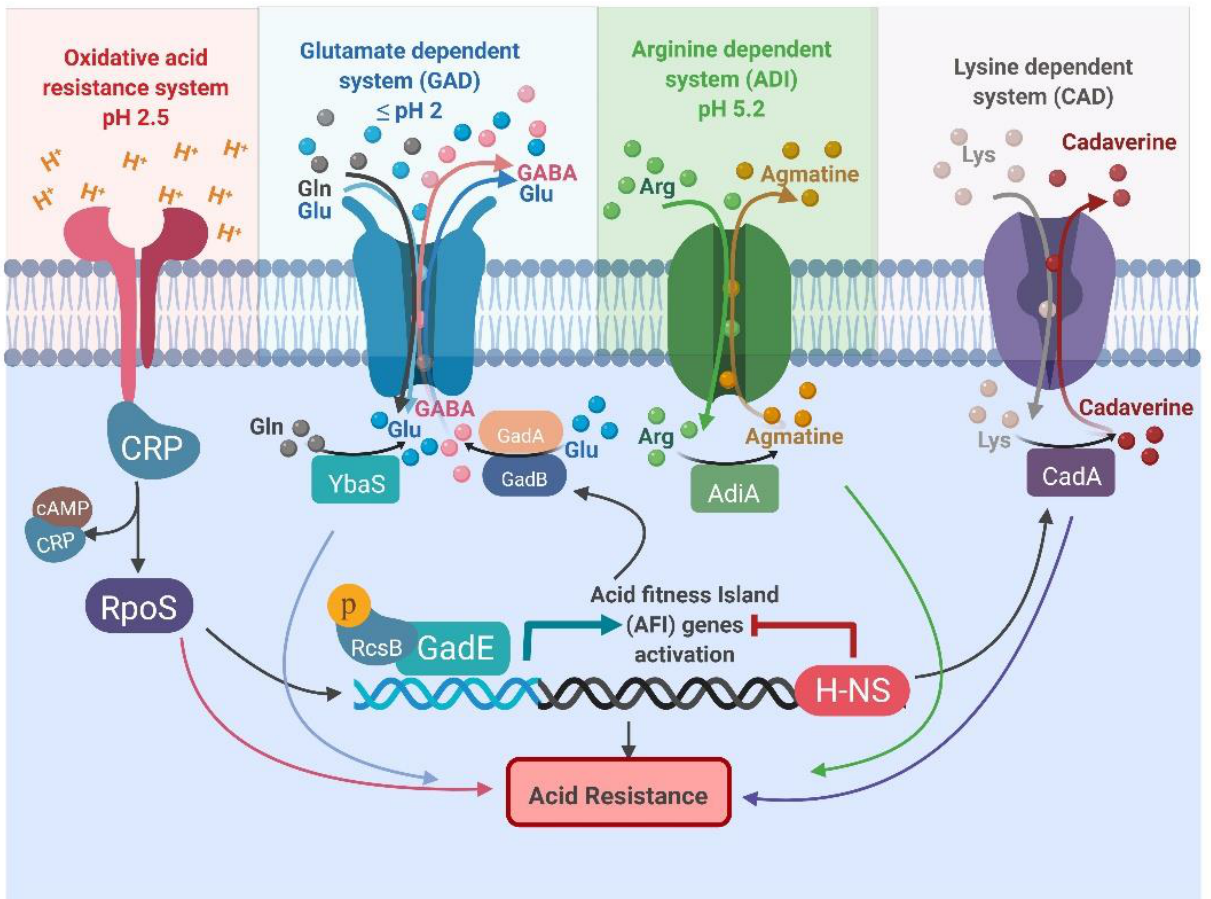
Figure 1. Representation of the oxidative, glutamate-dependent, arginine-dependent, and lysine-dependent acid resistance systems in Escherichia coli . All abbreviations are listed at the end of the manuscript.